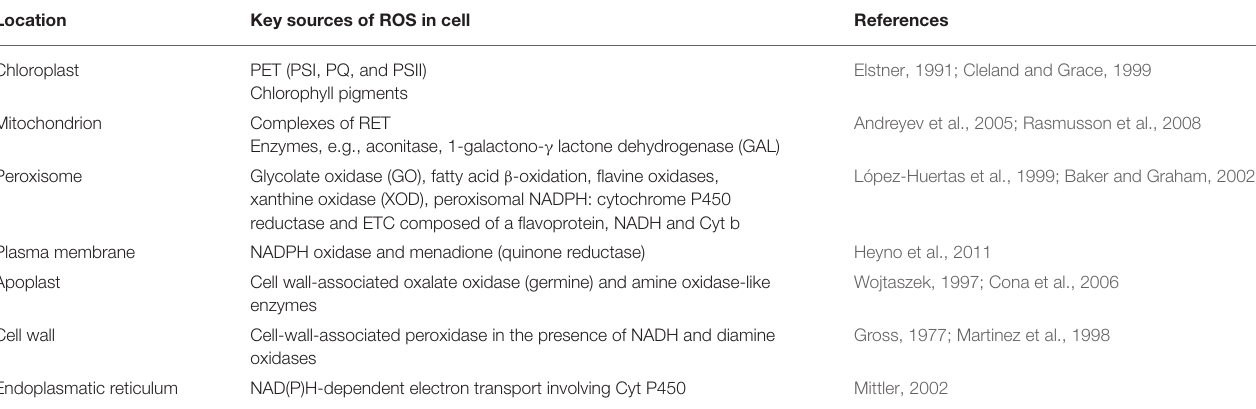
TABLE 1 | Generation sites and origin of reactive oxygen species (ROS) in plants.